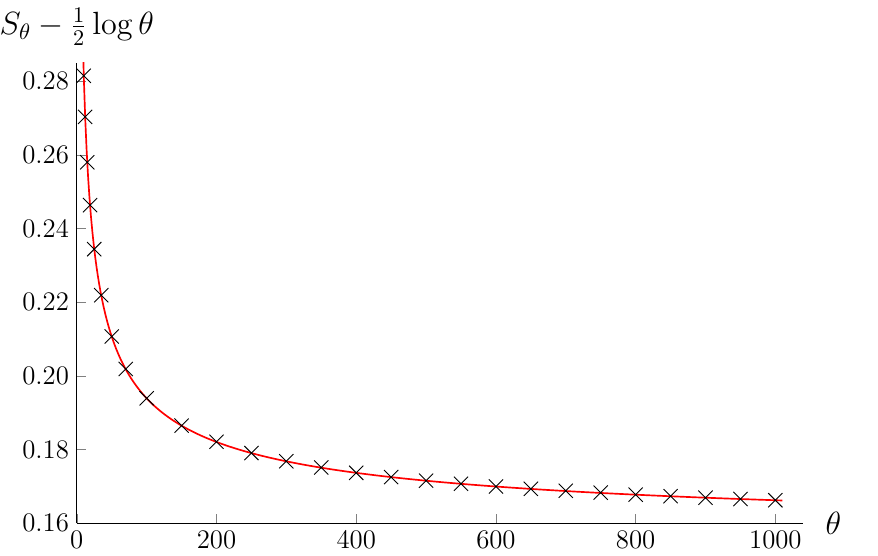
Figure 5. Entanglement entropy of the V (cid:18) -invariant state (3.8) substracting the term 1 = 2 log (cid:18) as a function of (cid:18) . The crosses correspond to the values obtained for S (cid:18) by diagonalizing numerically the reduced density matrix (3.9), restricting the indices to curve (cid:11) + (cid:12)= p (cid:18) (cid:12)tted to the numerical points in the interval (cid:18) and (cid:12) = 0 :